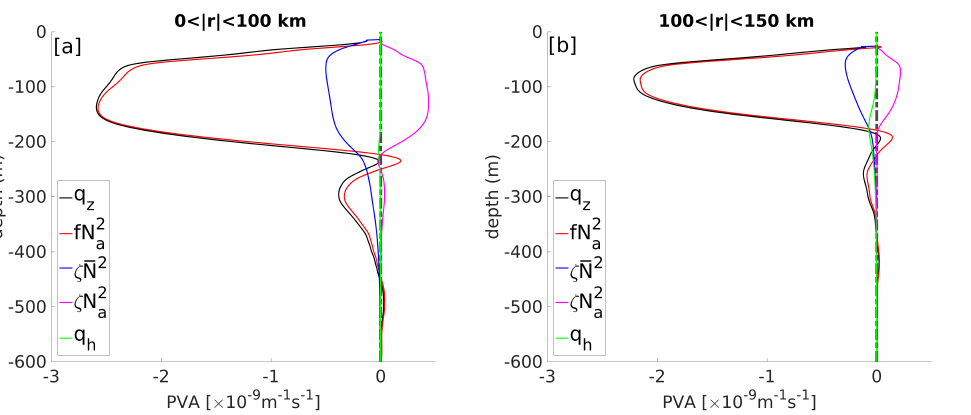
Figure 14. PVA profiles averaged over the core of the ring (0 < | r | < 100 km; panel ( a )) and over the periphery of the ring (100 km < | r | < 150 km; panel ( b )). The black line represents the vertical component of Ertel’s PV anomaly (PVA), the red line is the stretching term ( f N 2 a ), the blue line is the relative vorticity term ( ζ N 2 ), the pink line is the non linear term ( ζ N 2 a ), and the green line is the baroclinic component of PVA.